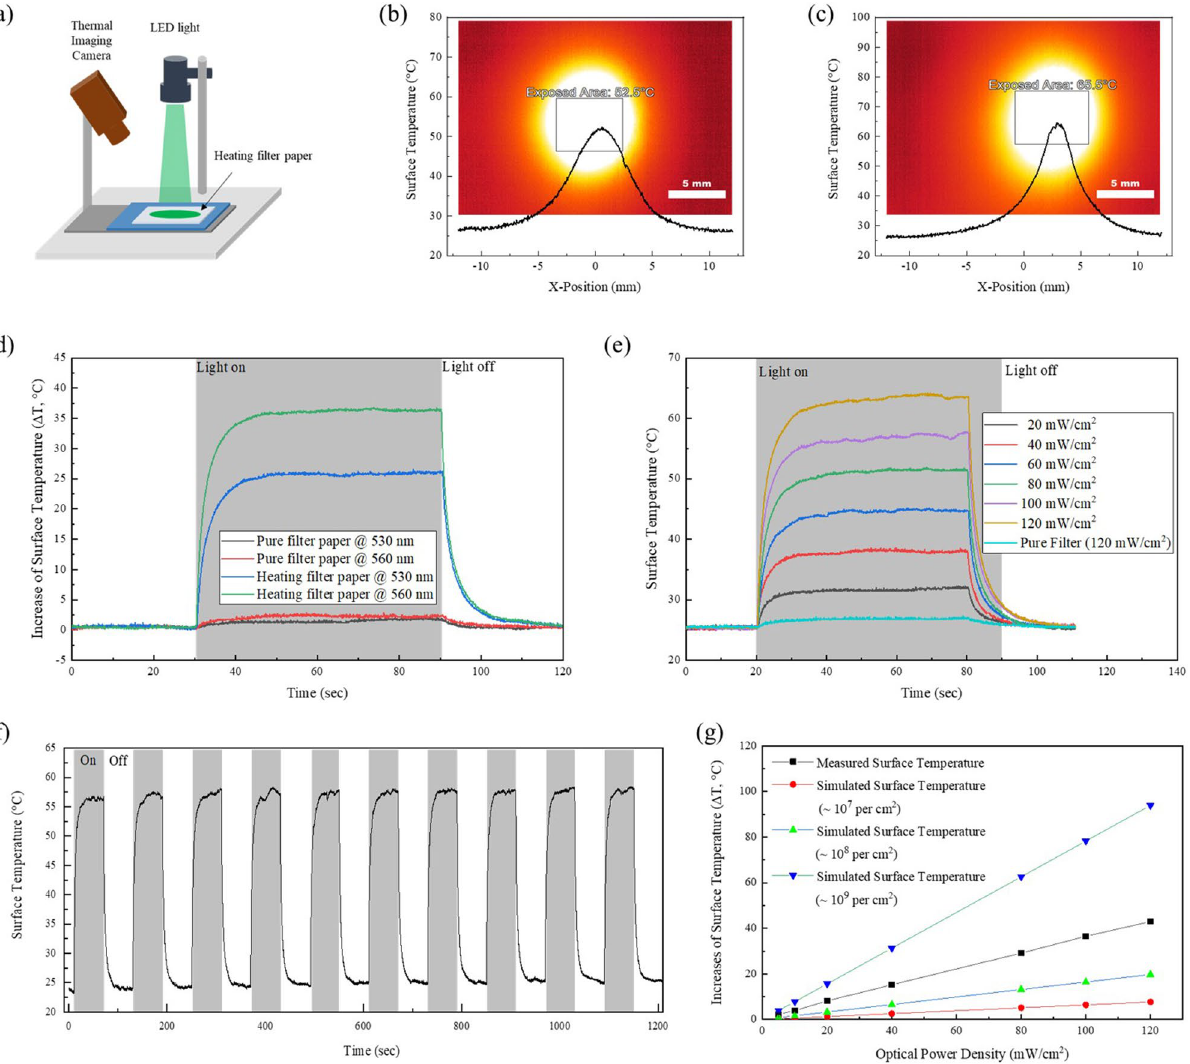
Figure 3. Evaluations of the photothermal effect of HFM. ( a ) Measurement set-up of the photothermal effect of the HFM under visible light irradiation (530 nm and 560 nm LED light sources). ( b , c ) TIC images and temperature profiles of the HFM under 530 nm and 560 nm LED light irradiation at an optical power density of 100 mW/cm 2 , respectively, at room temperature. The scale bar is 5 mm. ( d ) The measured surface temperature changes of HFM and PFM with respect to the wavelength of incident light, the wavelengths of incident light (530 nm and 560 nm). ( e ) The measured surface temperature of the HFM with respect to an incident optical power density of 560 nm LED irradiation at RT. For the PFM, the surface temperature was measured at an optical power density of 120 mW/cm 2 . ( f ) Repeatable heating plots of the HFM under 560 nm LED irradiation at an optical power density of 100 mW/cm 2 at room temperature. ( g ) Comparative plots of measured and simulated surface temperatures with respect to the optical power density of the incident light and the volume of Au NPs coated on the